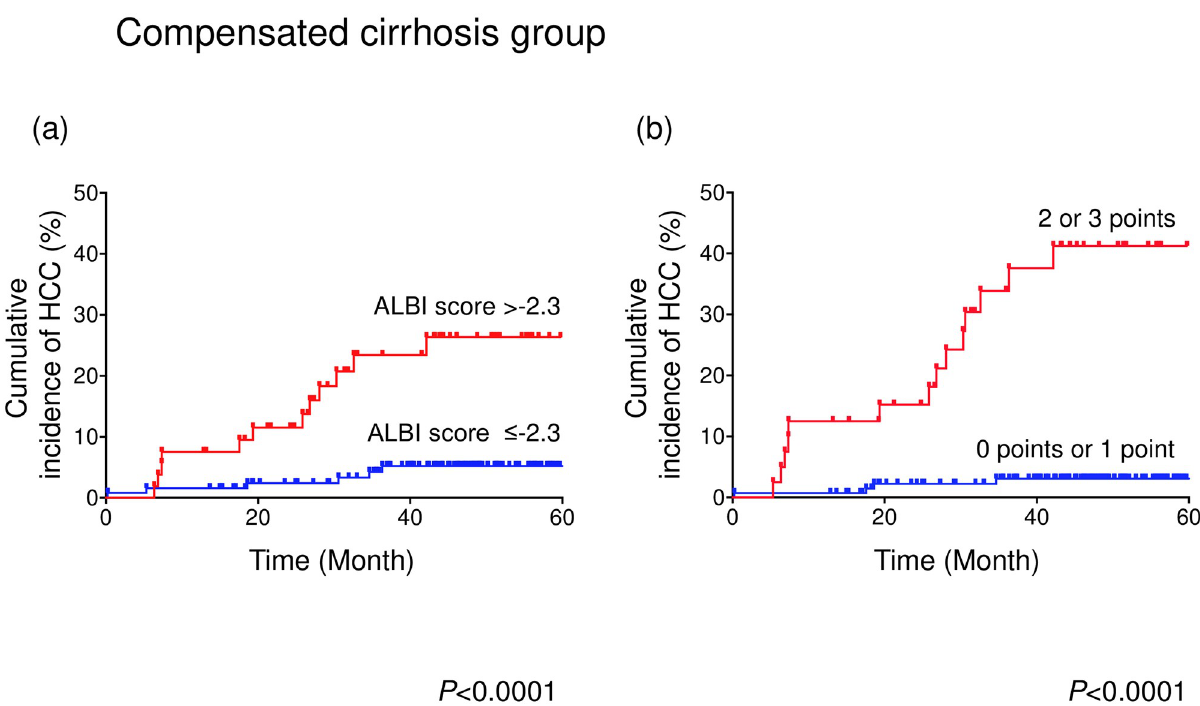
Fig 3. Comparison of the cumulative HCC incidence between compensated liver cirrhosis patients with HCV grouped according to factors that might contribute to the development of HCC after DAA treatment. (a) ALBI score > -2.3 (red line); ALBI score � -2.3 (blue line). (b) Score combining the ALBI score, PLT count, and presence of DM that was 2 or 3 points (red line) or 0 points or 1 point (blue line). The results were analyzed with the log-rank test.